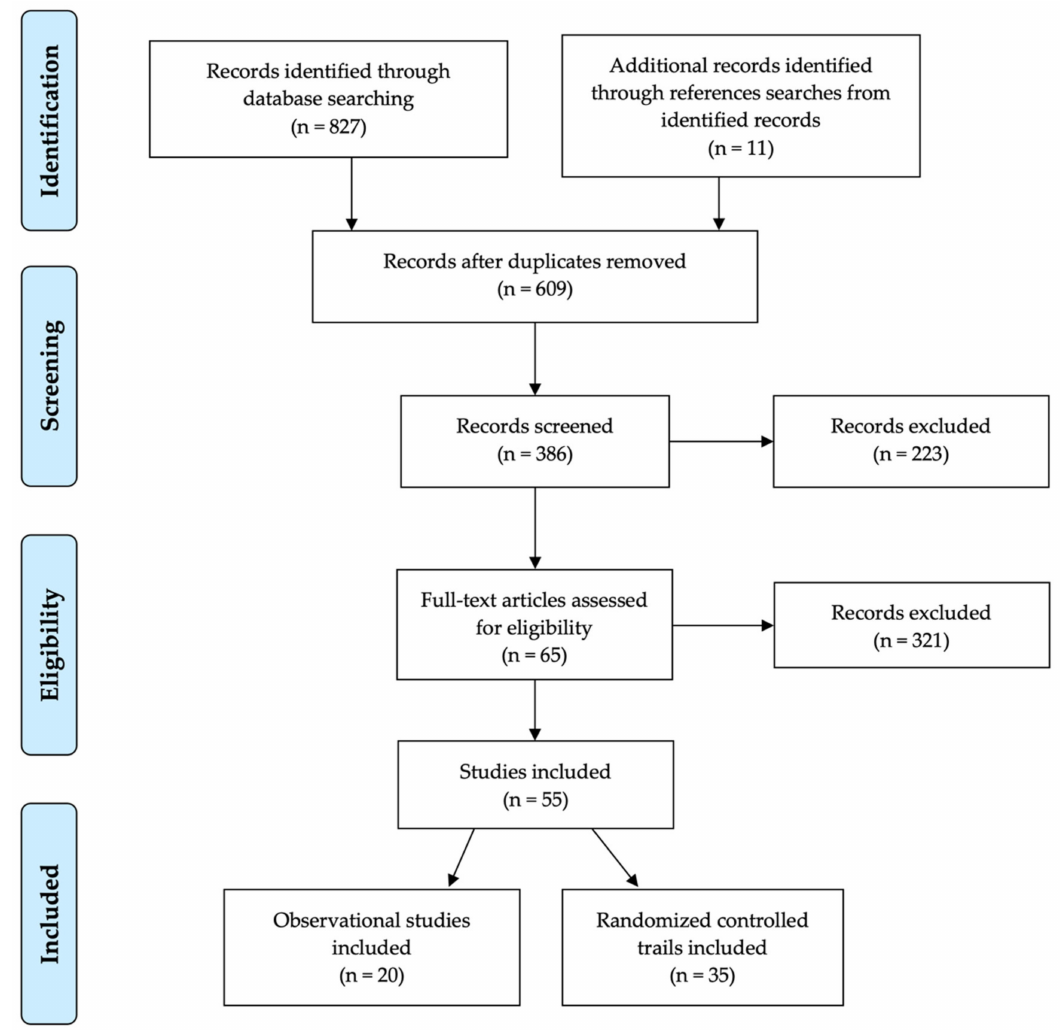
Figure 2. PRISMA flow chart, outlining the systematic review of xanthophyll carotenoids in the management of